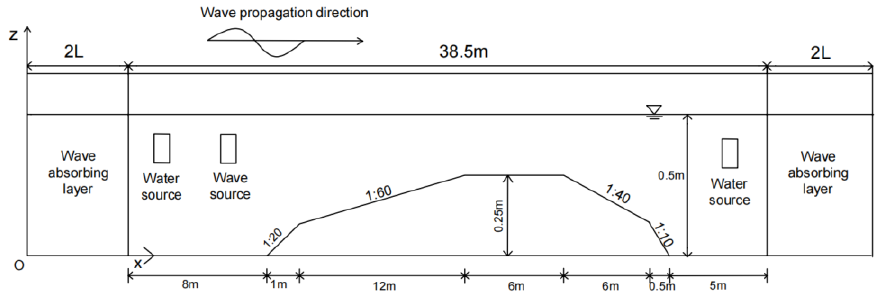
Figure 14. Schematic diagram of the submerged dike topographic wave flow interaction model. The theoretical values of the flow velocity distribution over the submerged dike to- pography: